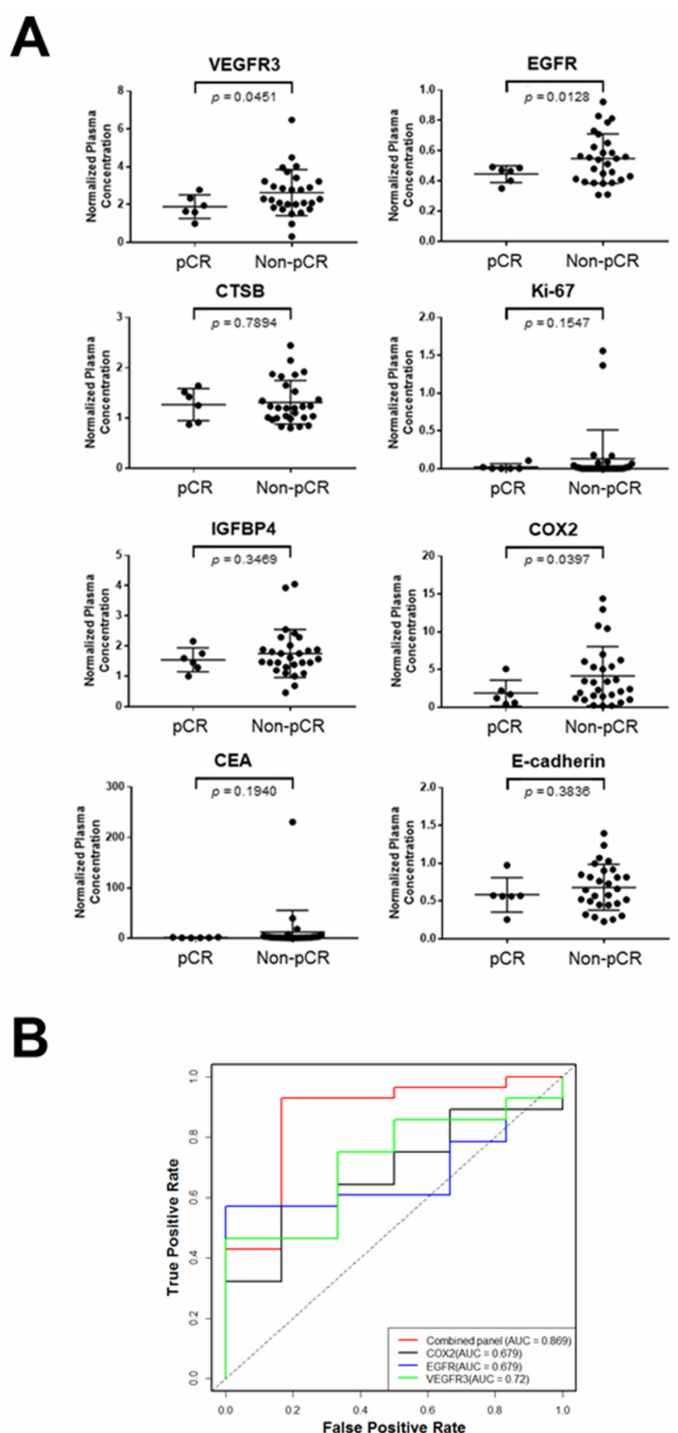
Figure 3. Validation of biomarker candidates in the pretreatment LARC set. ( A ). Levels of VEGFR3, CTSB, IGFBP4, CEA, EGFR, Ki-67, COX2, and E-cadherin in plasmas collected before nCRT from LARC patients who achieved pCR (pCR; n = 6) and LARC patients who had residual tumors after nCRT (non-pCR; n = 28). Horizontal lines indicate mean and standard deviation. p values were calculated using Welch’s t -test. ( B ). Receiver operating characteristic curves for VEGFR3, EGFR, COX2, and their combination in the pretreatment LARC set. CEA: Carcinoembryonic antigen, EGFR: Epidermal growth factor receptor, COX2: Prostaglandin G/H synthase 2, AUC: the area under the